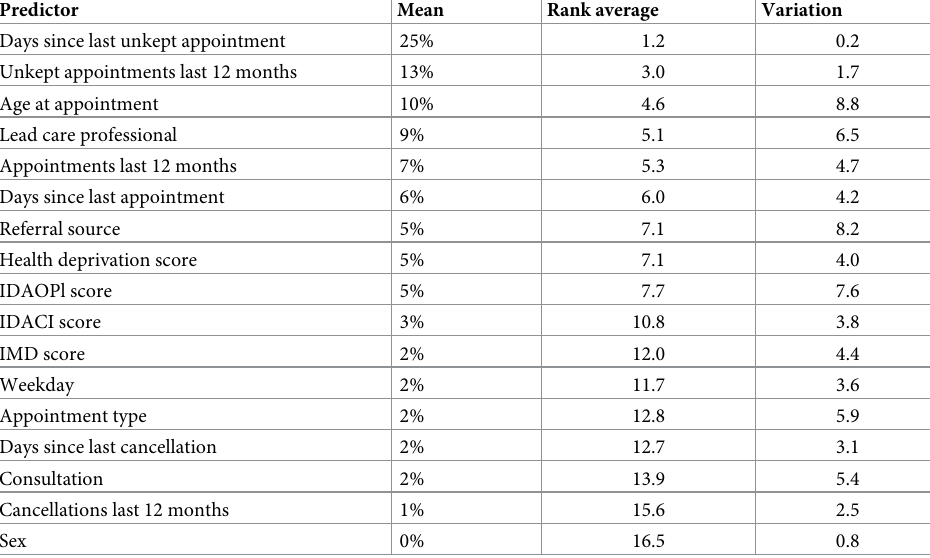
Table 3. Overall predictor